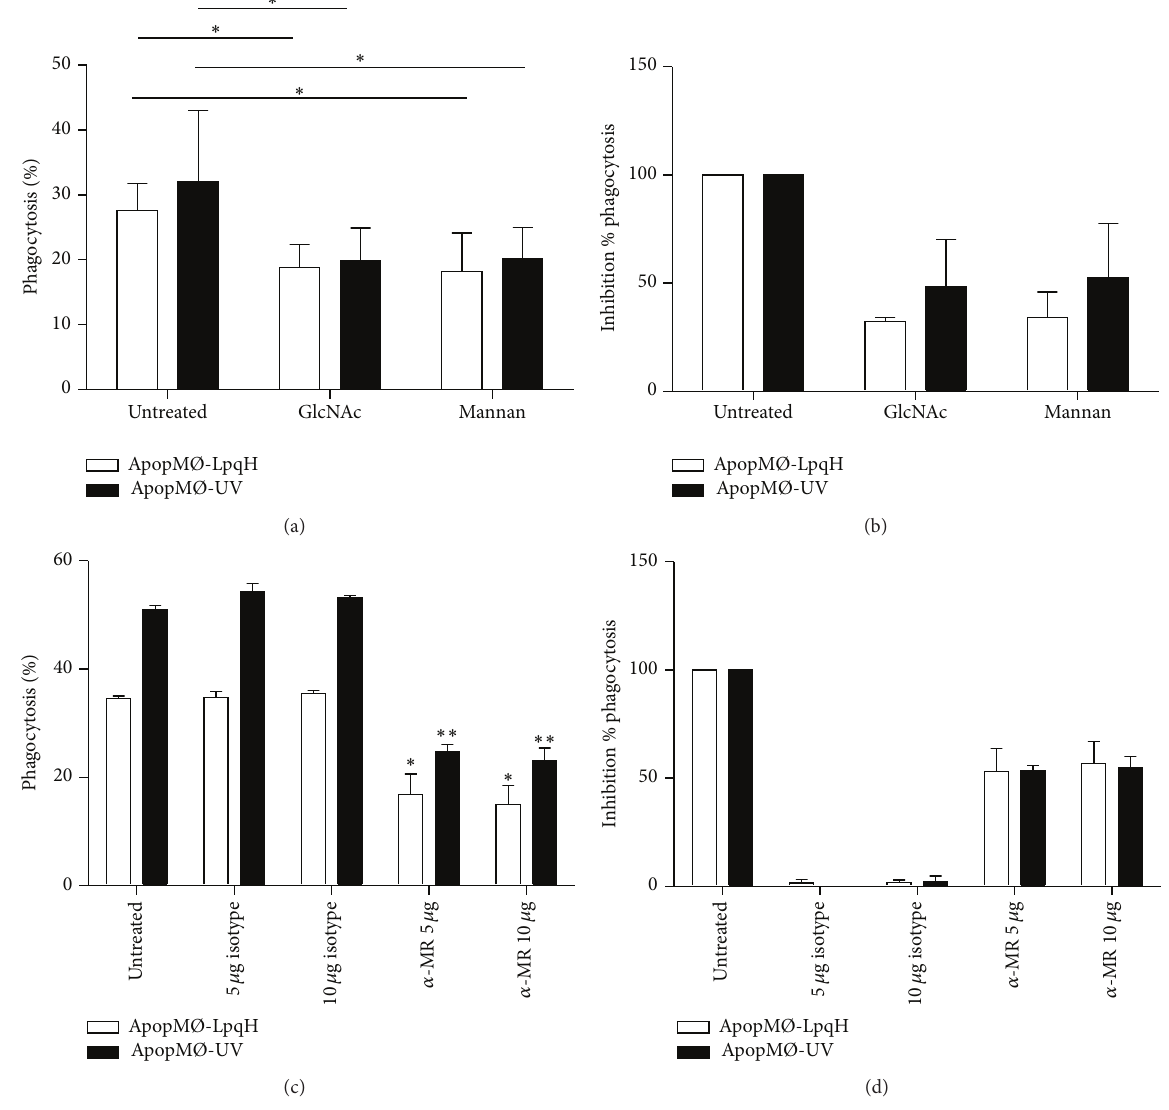
Figure 5: Competitive sugars GlcNAc and mannan and a blocking anti-MR antibody inhibit the phagocytosis of apoptotic cells. As determined by competitive inhibition assays, the preincubation of phagocytic cells with mannan and GlcNAc significantly reduced the degree of phagocytosis, expressed as the percent of cells with engulfed apoptotic bodies (a) or the percent inhibition of the phagocytosis (b). Preincubation with 5 and 10 𝜇 g of anti-MR antibody significantly reduced the percent of phagocytic cells (c). The percent inhibition of the phagocytosis is shown. The results of three independent experiments are presented. The isotype control had no inhibitory effects on the phagocytosis. Gaussian Student’s 𝑡 -test was used to assess statistical significance ( ∗ 𝑝 < 0.05 ; ∗∗ 𝑝 < 0.05